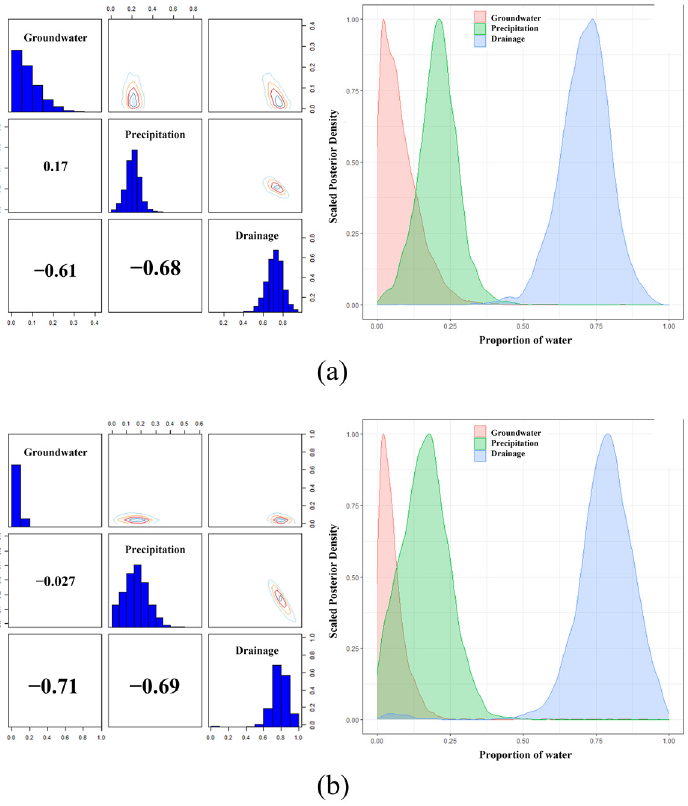
Figure 8. Contribution of the recharge of channel drainage, groundwater, and local precipitation to Wuliangsu Lake ( a ) in April 2021 and ( b ) in October 2021.